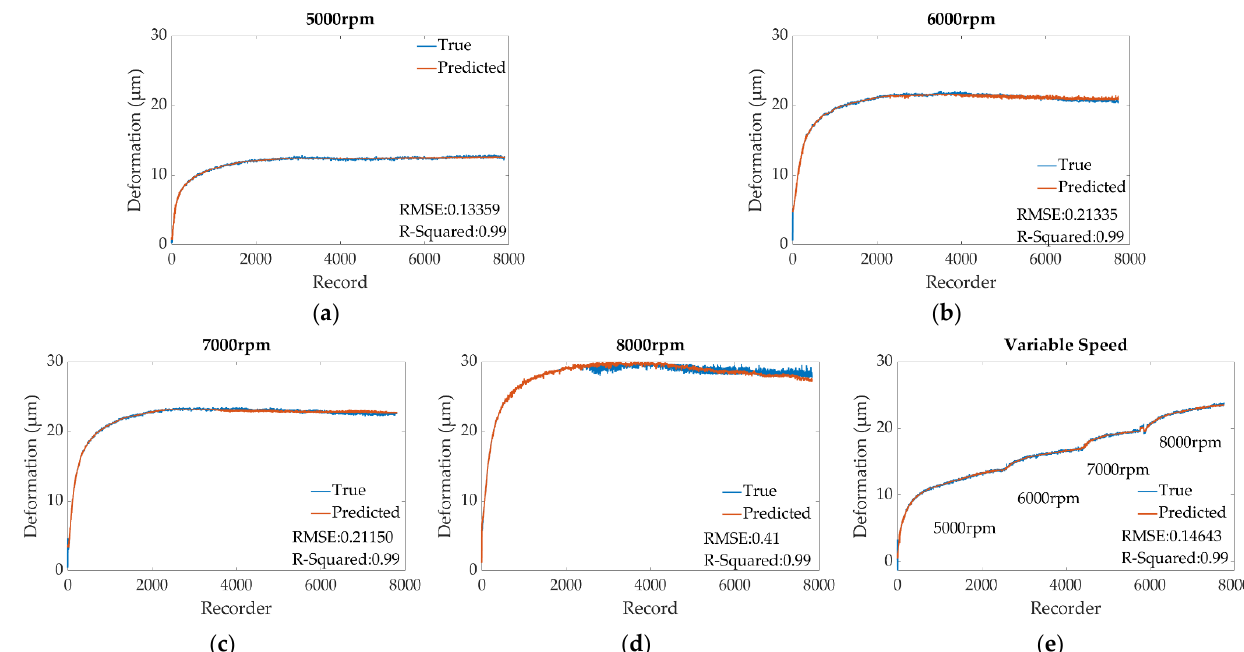
Figure 9. The self-validation of the thermal error model trained by random forests under the rotational speed of ( a ) 5000 rpm; ( b ) 6000 rpm; ( c ) 7000 rpm; ( d ) 8000 rpm; ( e ) variable speed.